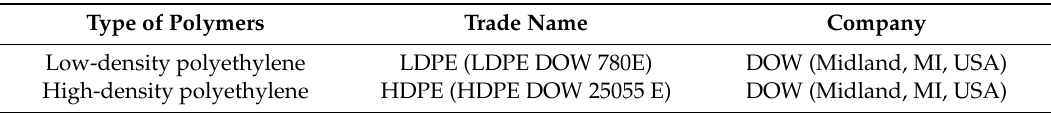
Table 1. Tested polymers.